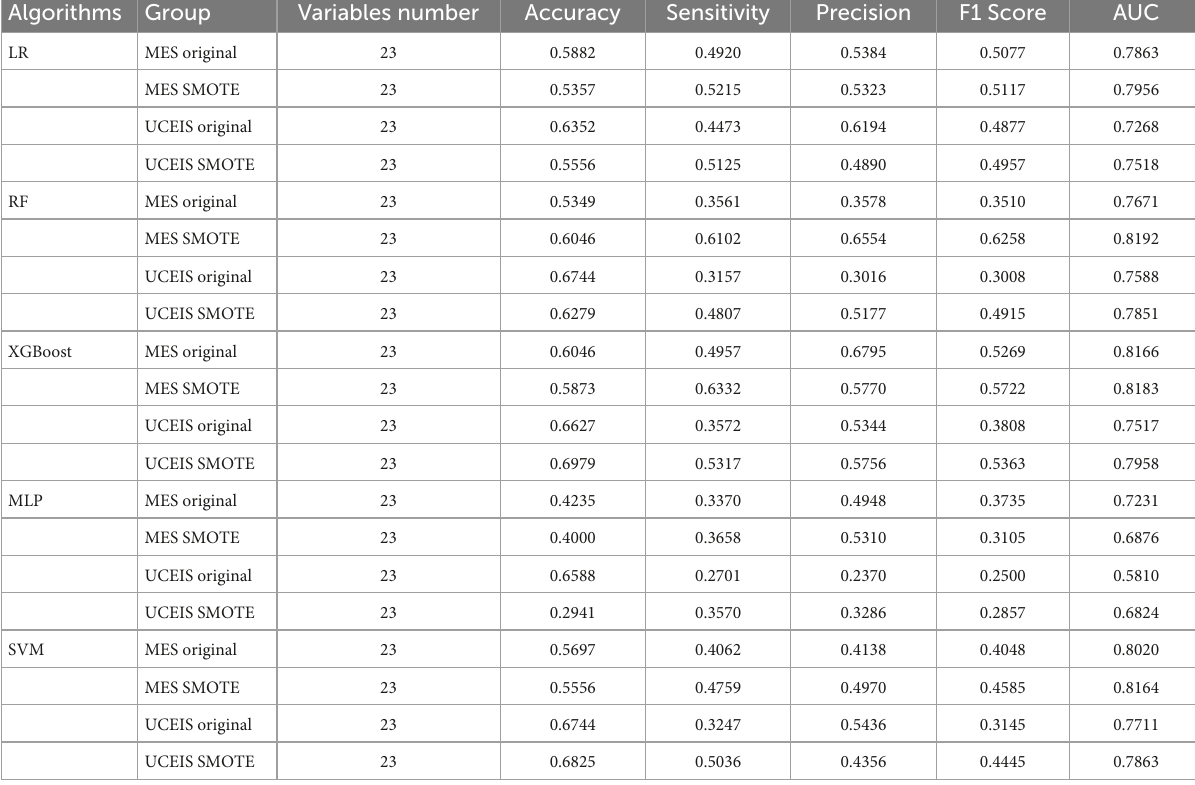
TABLE 2 The performance of the models with all variables in the test set.